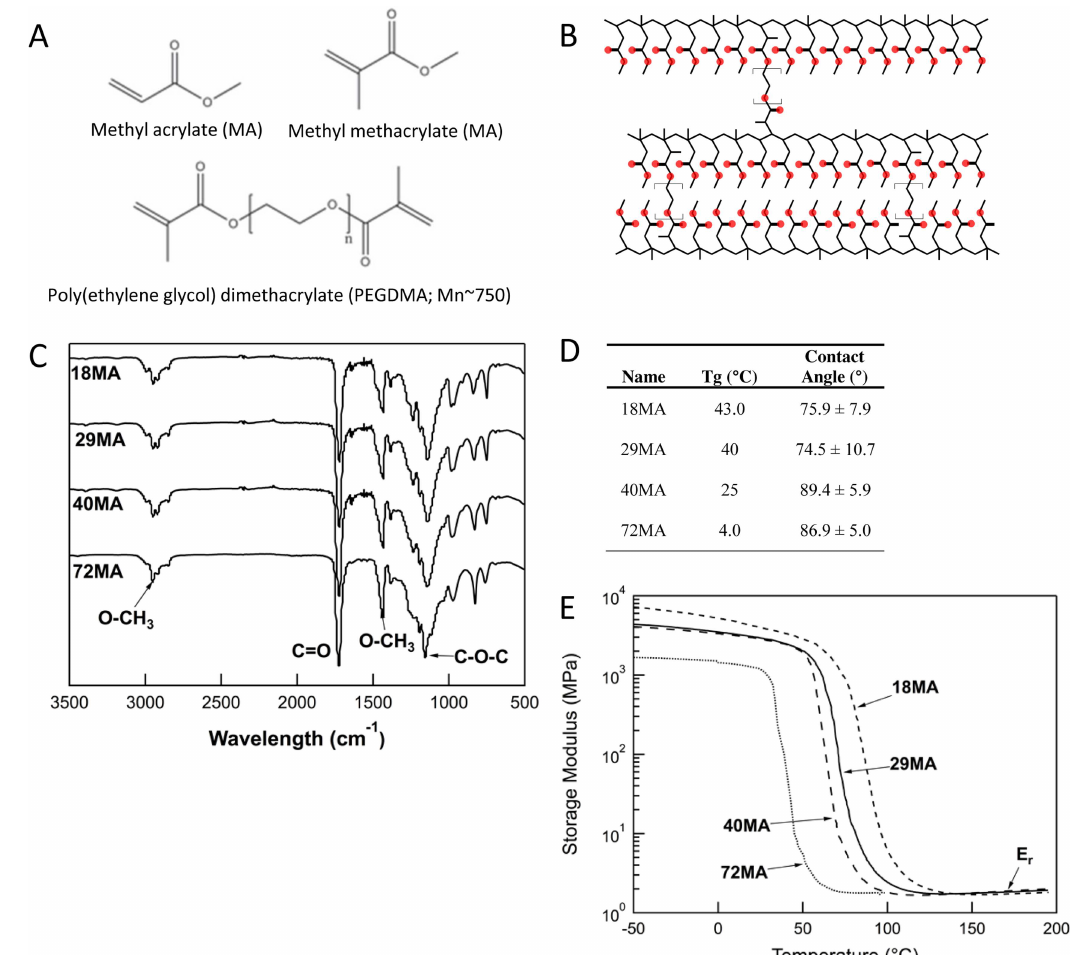
Fig 1. Characterization of MA-MMA networks. (A) Monomers used to create networks of increasingstiffness. (B) Exampleof crosslinkednetwork. (C) Representative FTIR-ATR spectra for each network indicating similar surface chemistry for each. (D) Glass transition temperature (Tg) and contact angle of crosslinked networks. (E) DMA of crosslinkednetworks(n =